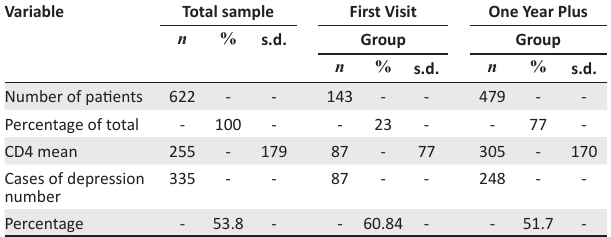
TABLE 4: Prevalence of cases of depression in First Visit Group compared to the One Year Plus